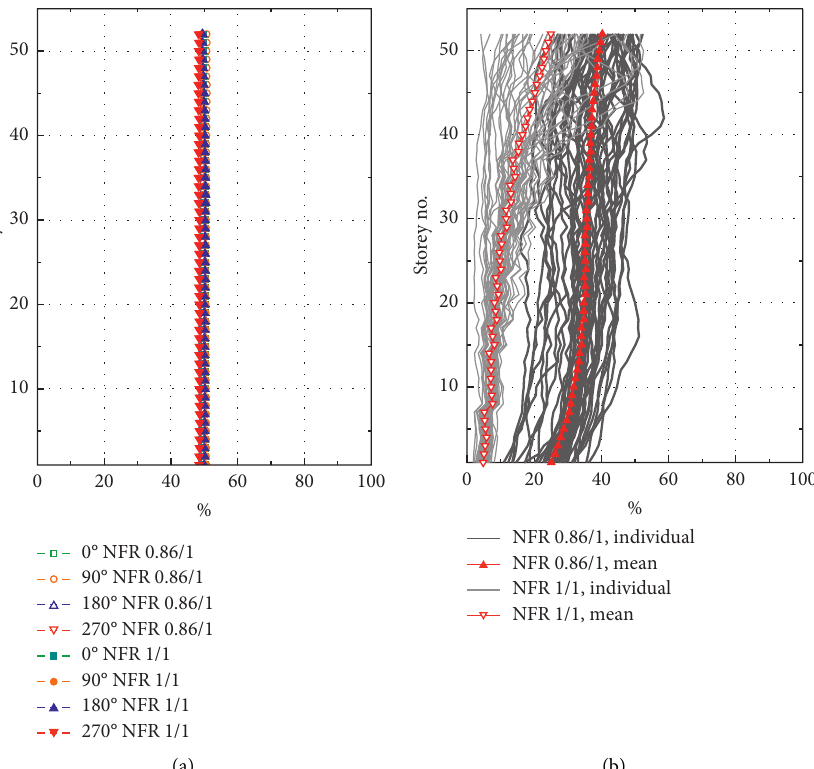
Figure 11: Variation of opposite-sign velocity factor with height of buildings under (a) wind loads and (b) 44 earthquake